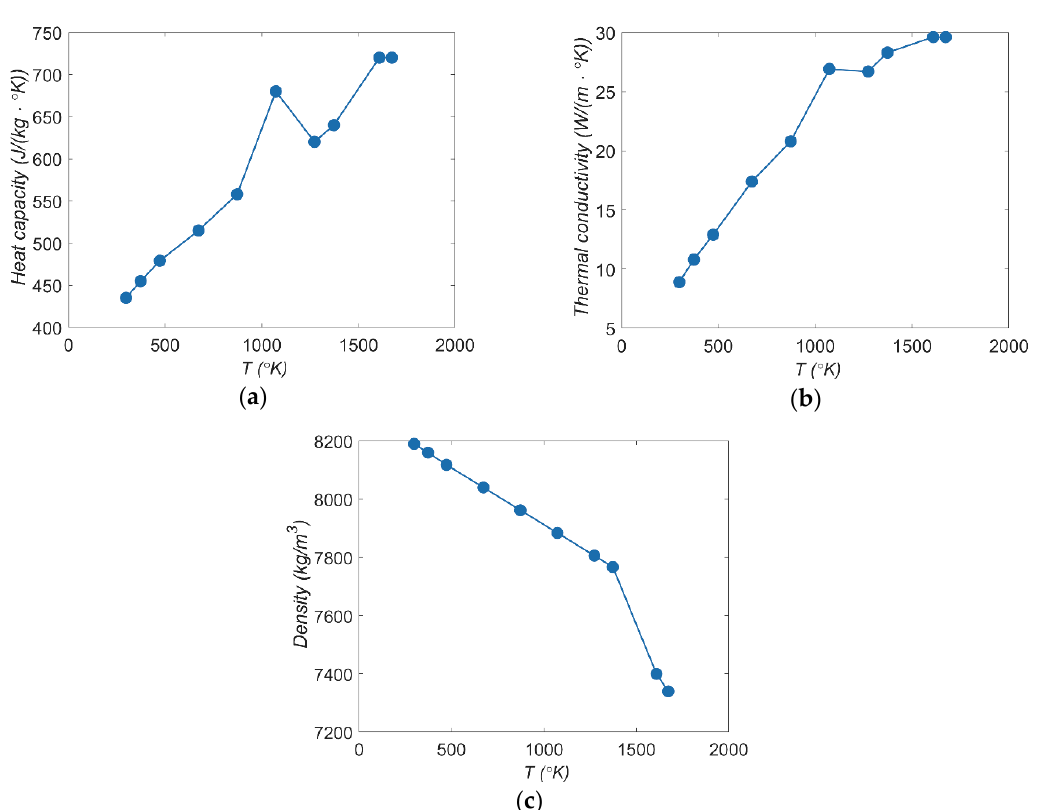
Table 1. The chemical composition of Inconel 718 (wt. %).